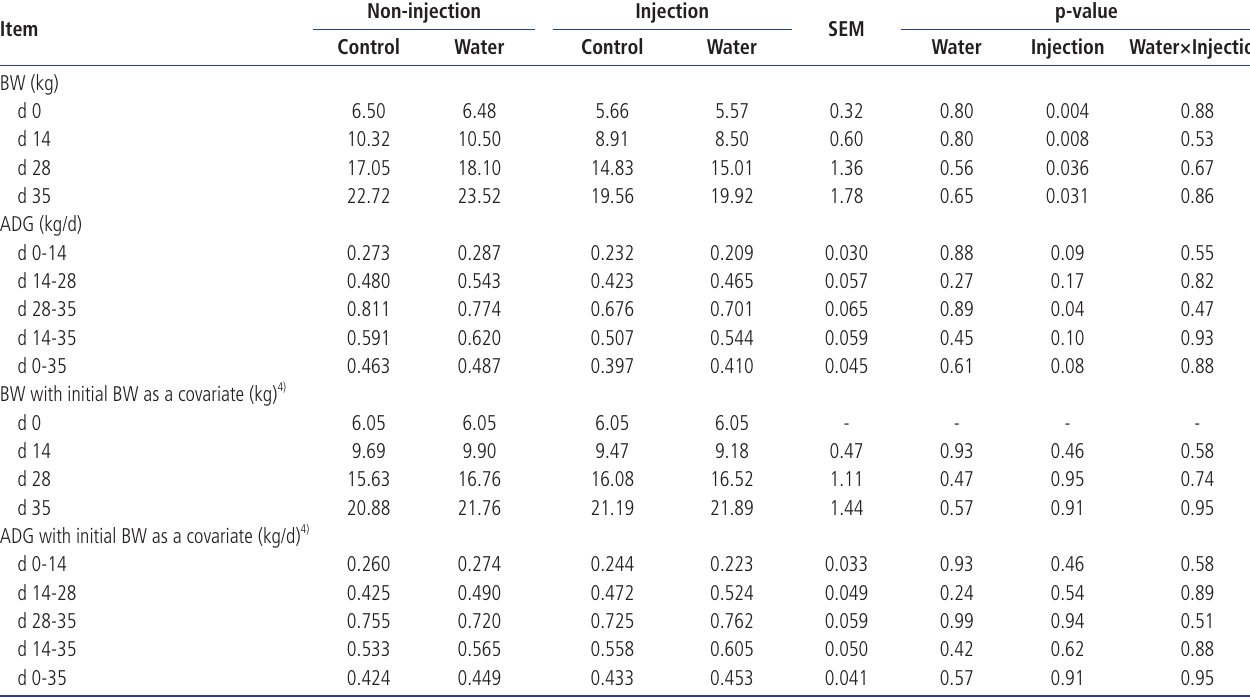
and E administration in drinking water with or without vitamin A, D 3 Non-injection Injection